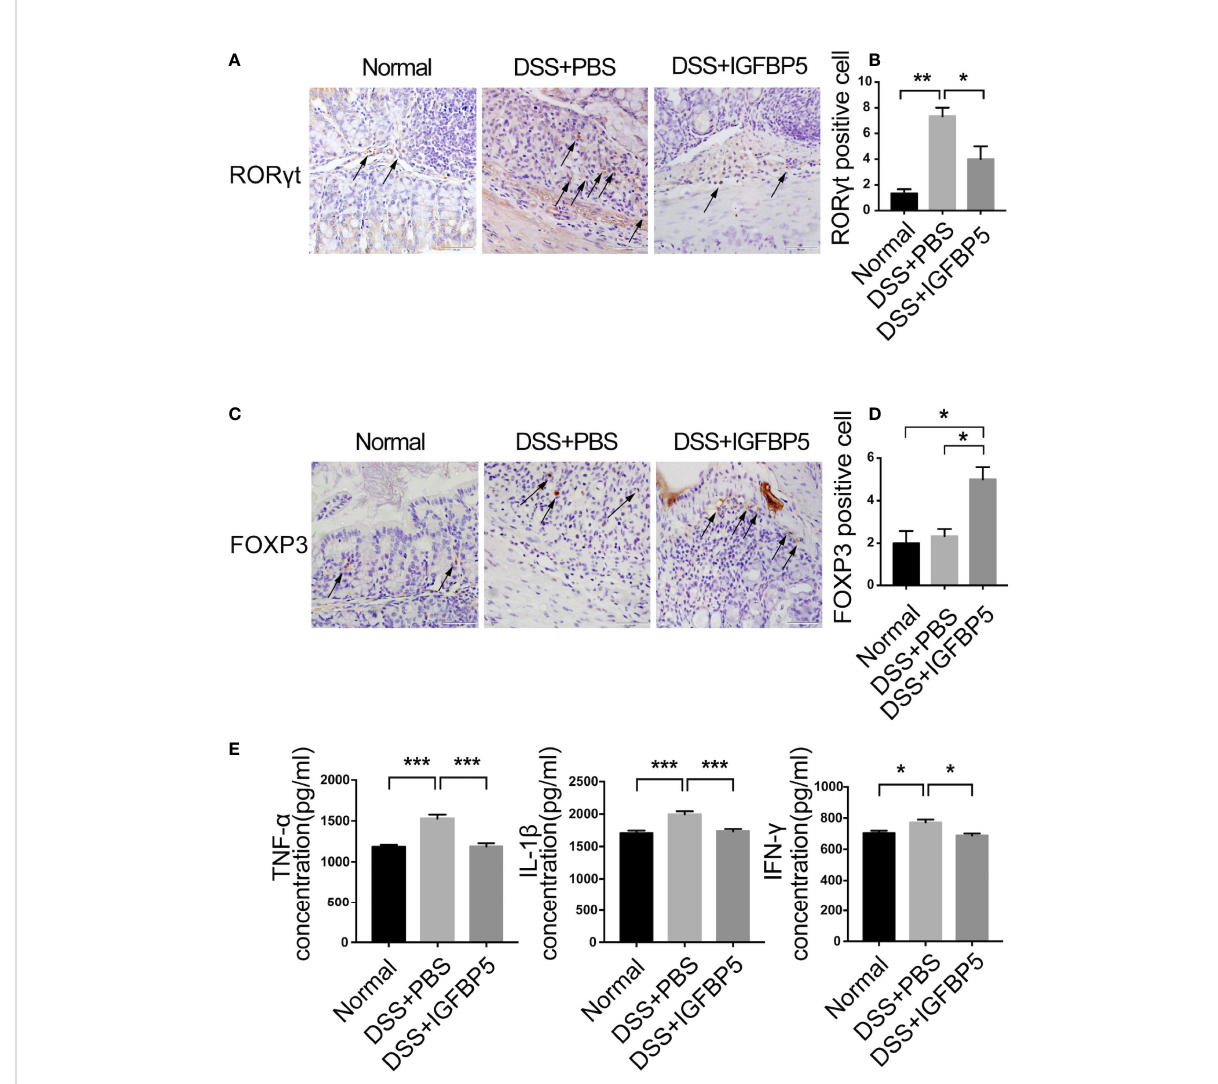
FIGURE 4 IGFBP5 maintained the balance of mucosal Th17/Treg in the in fl amed colon. The expression of (A) ROR g t and (C) FOXP3 in colon tissue were detected by immunohistochemistry (4× and 20×), and the quantitative analysis of ROR g t and FOXP3 positive cells were shown respectively, in (B) and (D) . (E) The concentrations of TNF- a 、 ; IL- b and IFN- g in the serum of mice in each group were determined by ELISA (n=5). The experiment was repeated three times independently. One-way ANOVA was used to determine statistical signi fi cance. The data are presented as the mean ± SEM. * p < 0.05, ** p < 0.01, *** p <